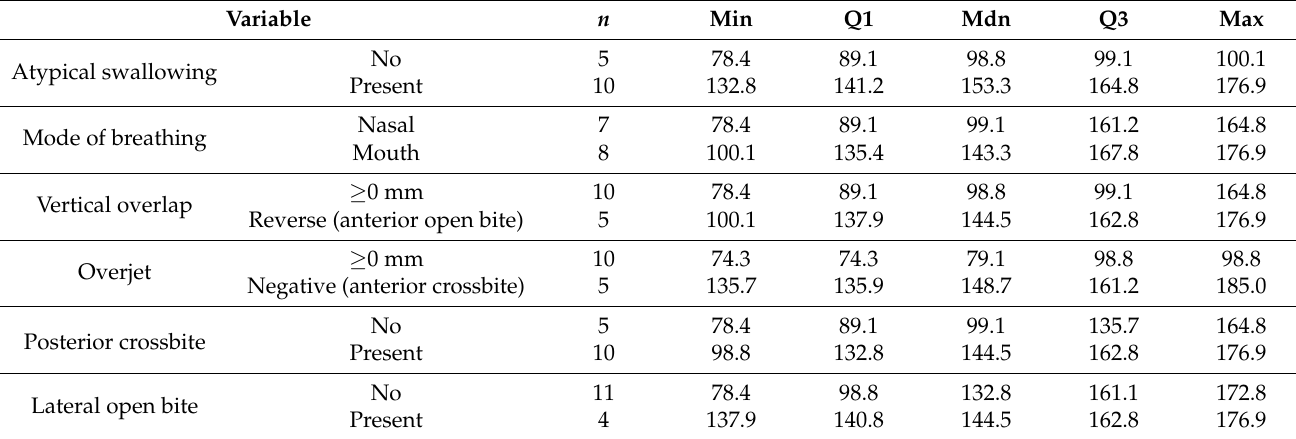
Table 5. Electrical activity of the inferior orbicularis oris muscle [ µ V/ µ V%] during saliva swallowing in the DS group.